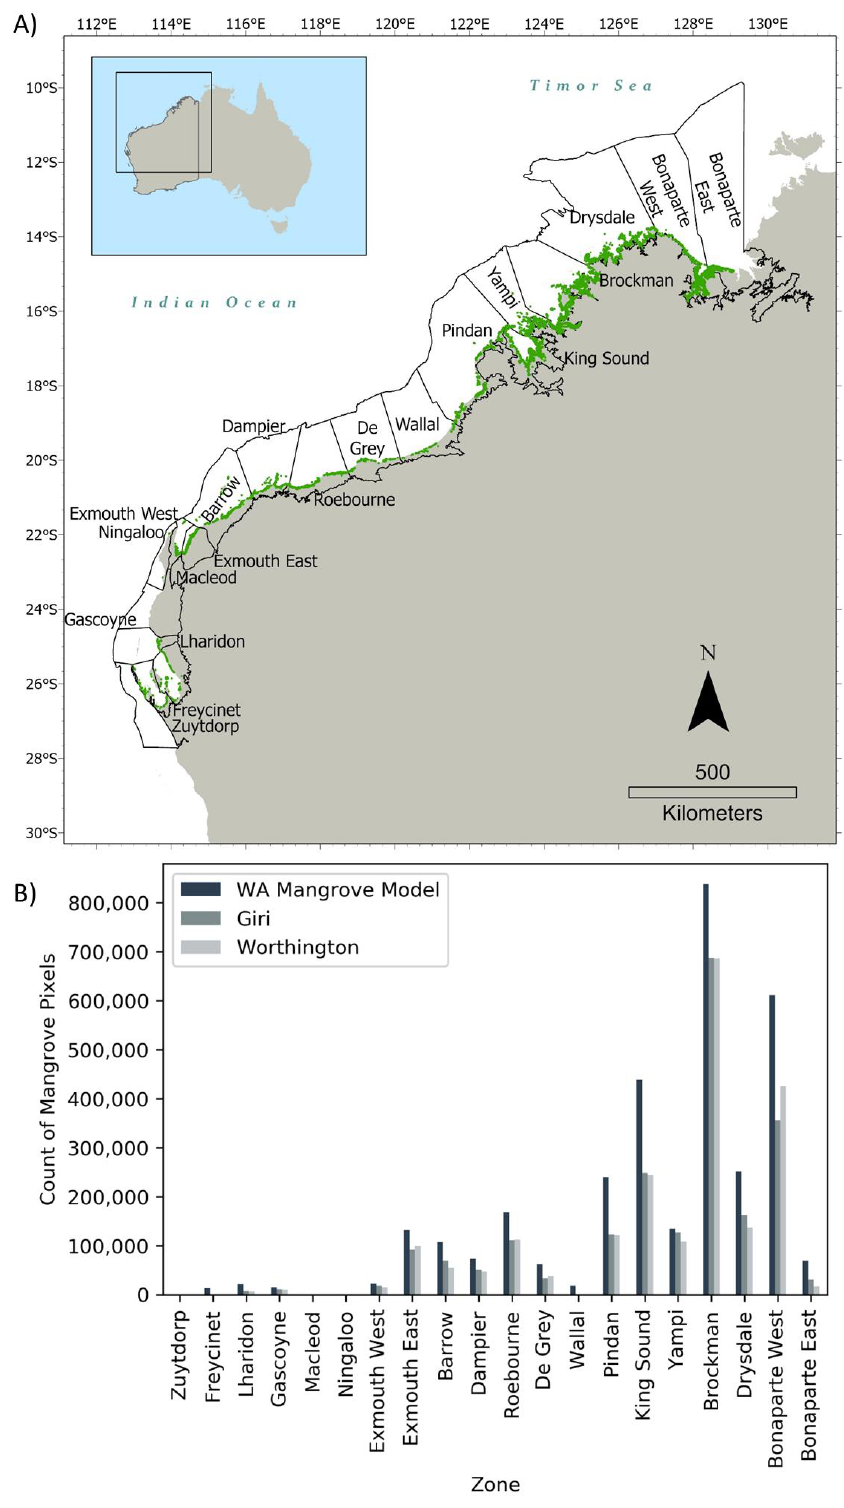
Figure 4. ( A ) The extent of the optimal mangrove layer generated using annual composites. ( B ) Overall mangrove area for each sedimentary zone along the North-west Australian coastline. Note: Bonaparte East is restricted to the Western Australia border boundary. Giri refers to layer in ref. [12], Worthington refers to layer in ref.